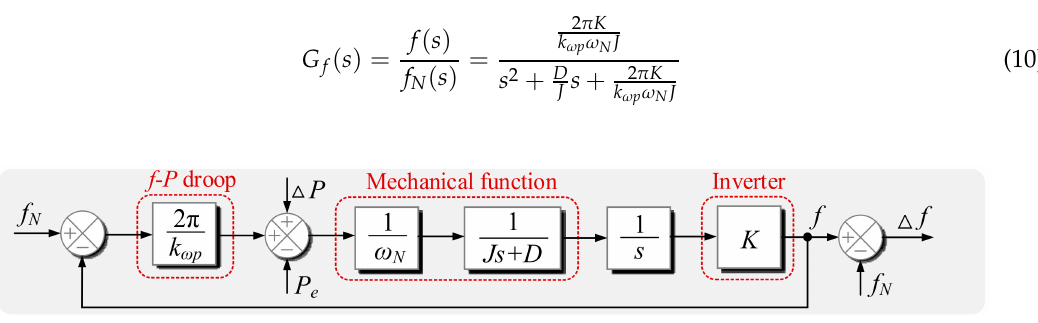
Figure 6. Small-signal model for VSG’s frequency regulation